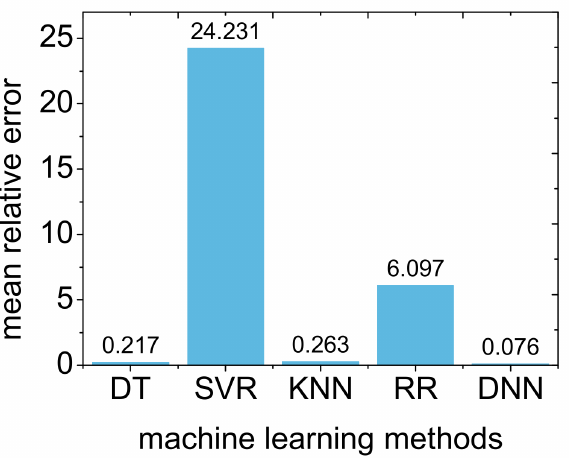
Figure 8. Comparison of the mean relative errors for drain transient current pulses as predicted by the traditional machine learning method and deep neural network